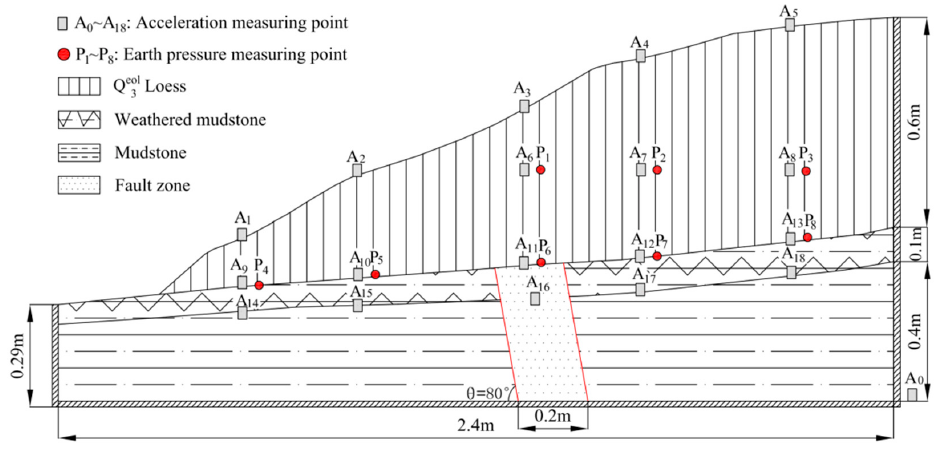
Figure 4. Side view of sensors distribution.